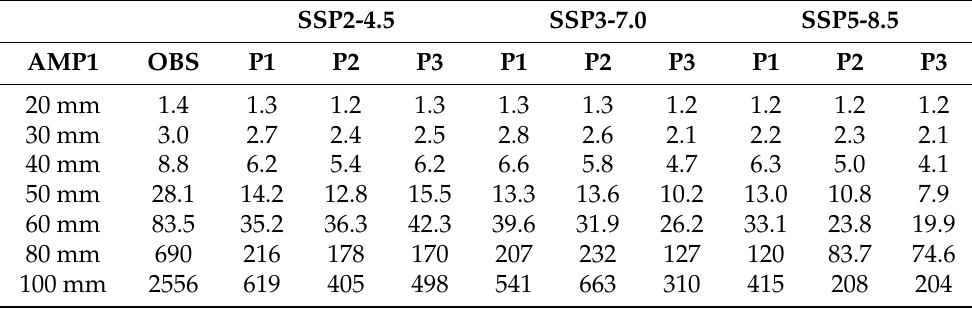
Table 3. The expected waiting time (unit: year) until reoccurrence of specific annual maximum daily precipitation (AMP1) values from 20 to 100 mm in the Iran obtained from the observations (OBS) and the CMIP6 model ensemble under the three SSP scenarios for three future periods (P1, P2, and